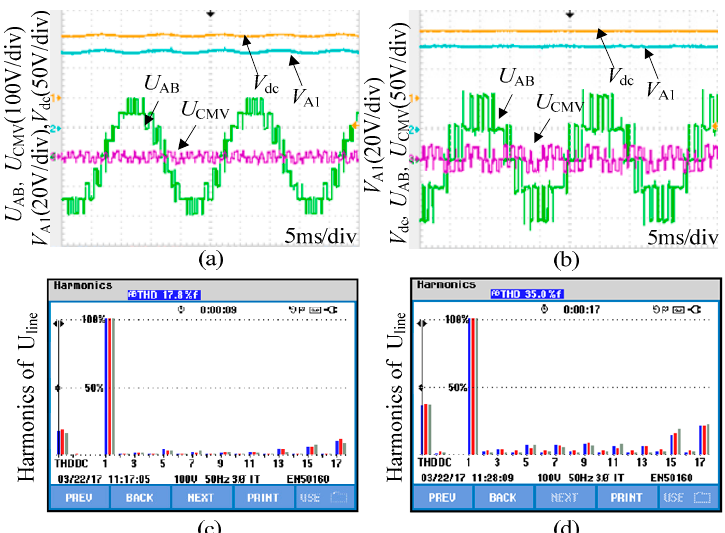
Figure 13. The experimental results of steady-state operation. ( a ) The DC-side voltage, the capacitance voltage of phase A, line voltage between phase A and phase B, and common-mode voltage when m is 0.9; ( b ) The DC-side voltage, the capacitance voltage of phase A, line voltage between phase A and phase B, and common-mode voltage when m is 0.4; ( c ) The harmonic analysis of the line voltage when m is 0.9; and ( d ) The harmonic analysis of the line voltage when m is